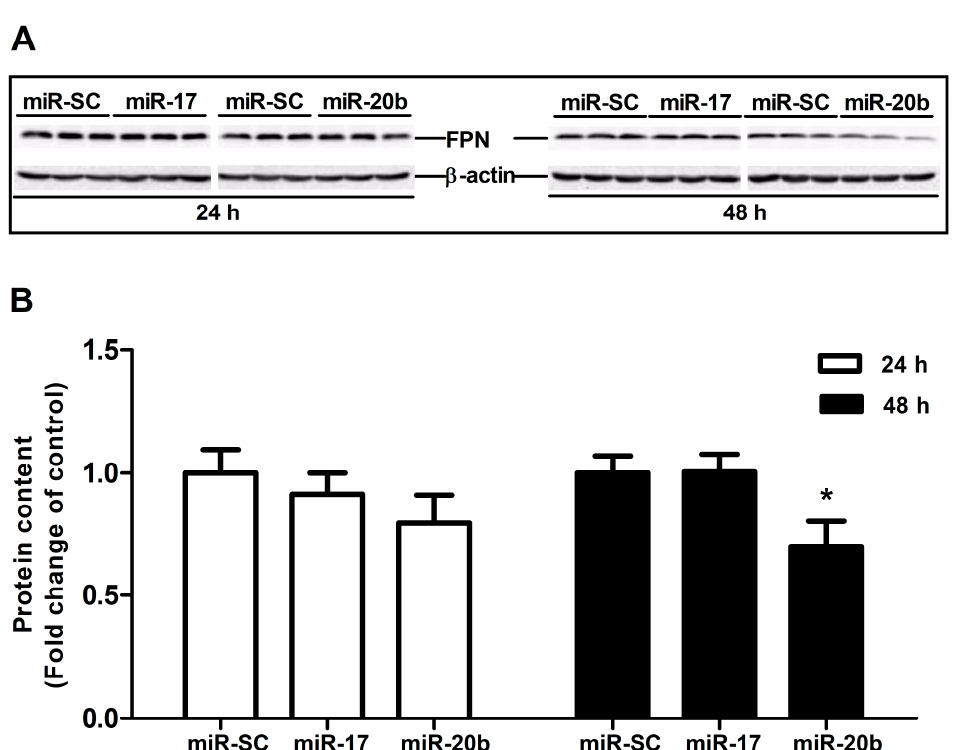
Figure 5. E ff ect of miR-17 and miR-20b on endogenous FPN expression in vitro. ( A ) The protein expression of FPN was evaluated by Western blot in Caco-2 cells transfected with miR-17, miR-20b, and vector control (miR-SC) for 24 h and 48 h. ( B ) Bar graphs representing quantification of FPN protein expressions normalized to β -actin. Values were expressed as means ± SEM, n = 6 in each group, * p <